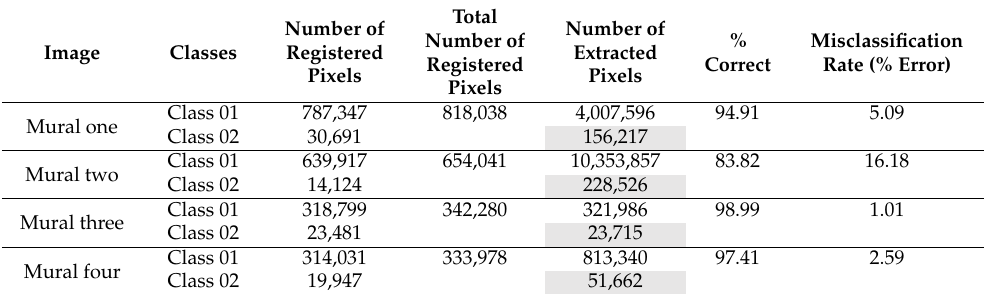
Table 3. Classification summary and the number of extracted pixels after applying the MD approach of mural paintings of Mogao